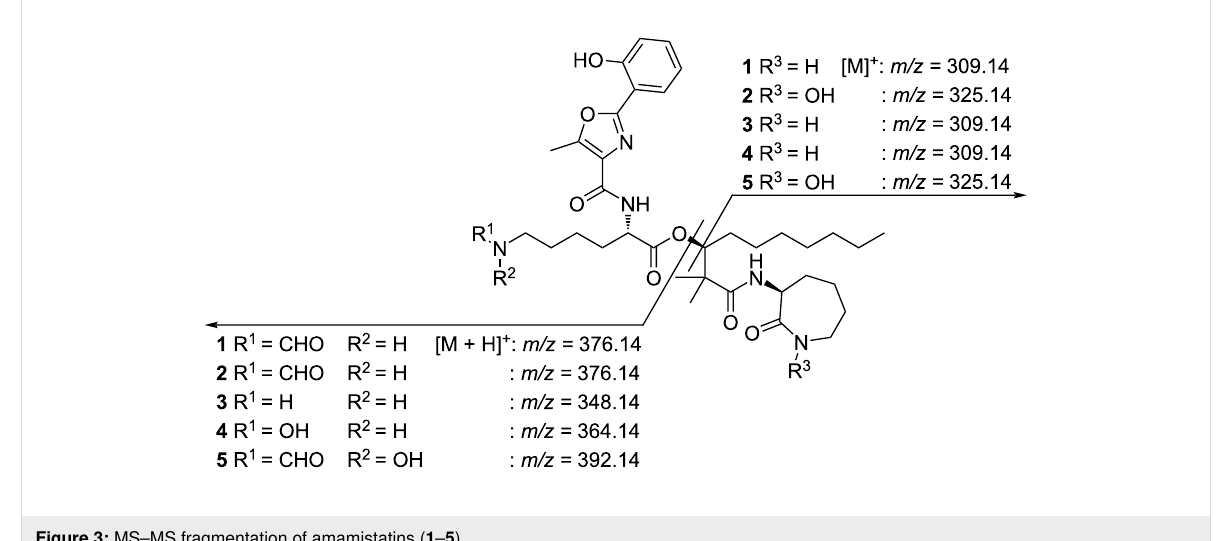
presence of an additional oxygen atom. A comparison of the NMR data with 3 revealed that the chemical shifts of CH 2 -24 are significantly shifted upfield. In contrast, all other reso- nances are highly conserved and no difference in the splitting pattern was observed. This suggests the presence of an electron- donating hydroxy group next to the ε -amino group in the lysine moiety. The assumption of a hydroxylamine function is consis- tent with tandem MS data, which showed mass shifts of 16 Da in the corresponding region in comparison to compound 3 .